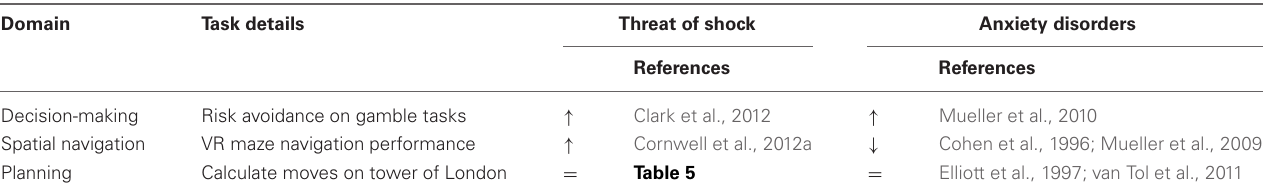
Table 6 | Effects of anxiety on executive functions (arrows represent direction of effect).